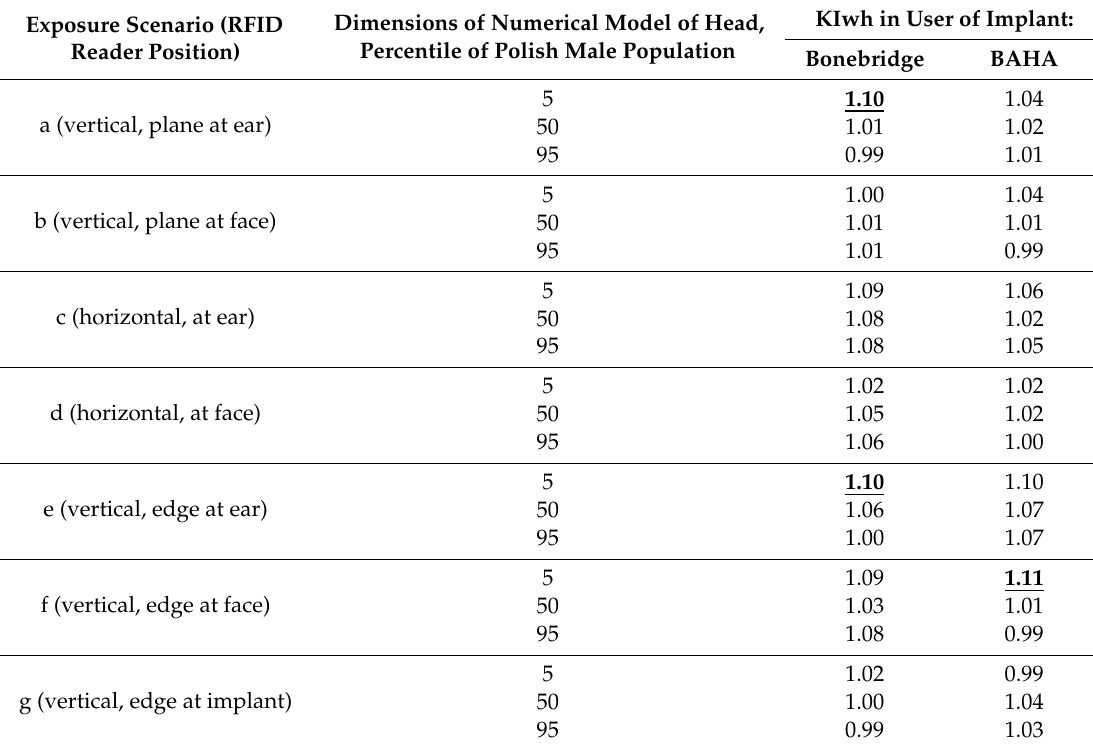
Table 1. Comparison of the whole head averaged specific energy absorption rate (SAR) (SARwh) under exposure to an EMF at a frequency of 13.56 MHz (emitted by an RFID HF reader) in the head of a hearing implant user and a